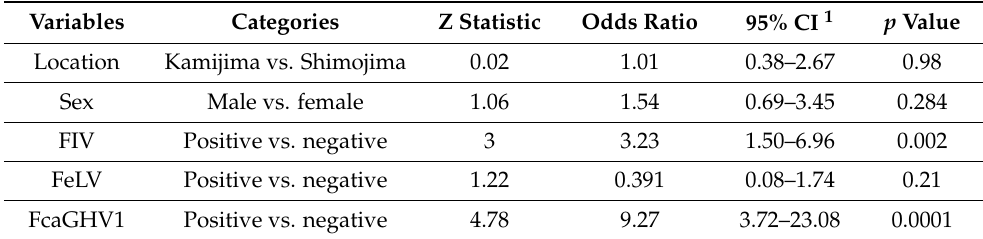
Table 4. Univariable logistic regression analysis to evaluate the association between variables and FFV detection in domestic